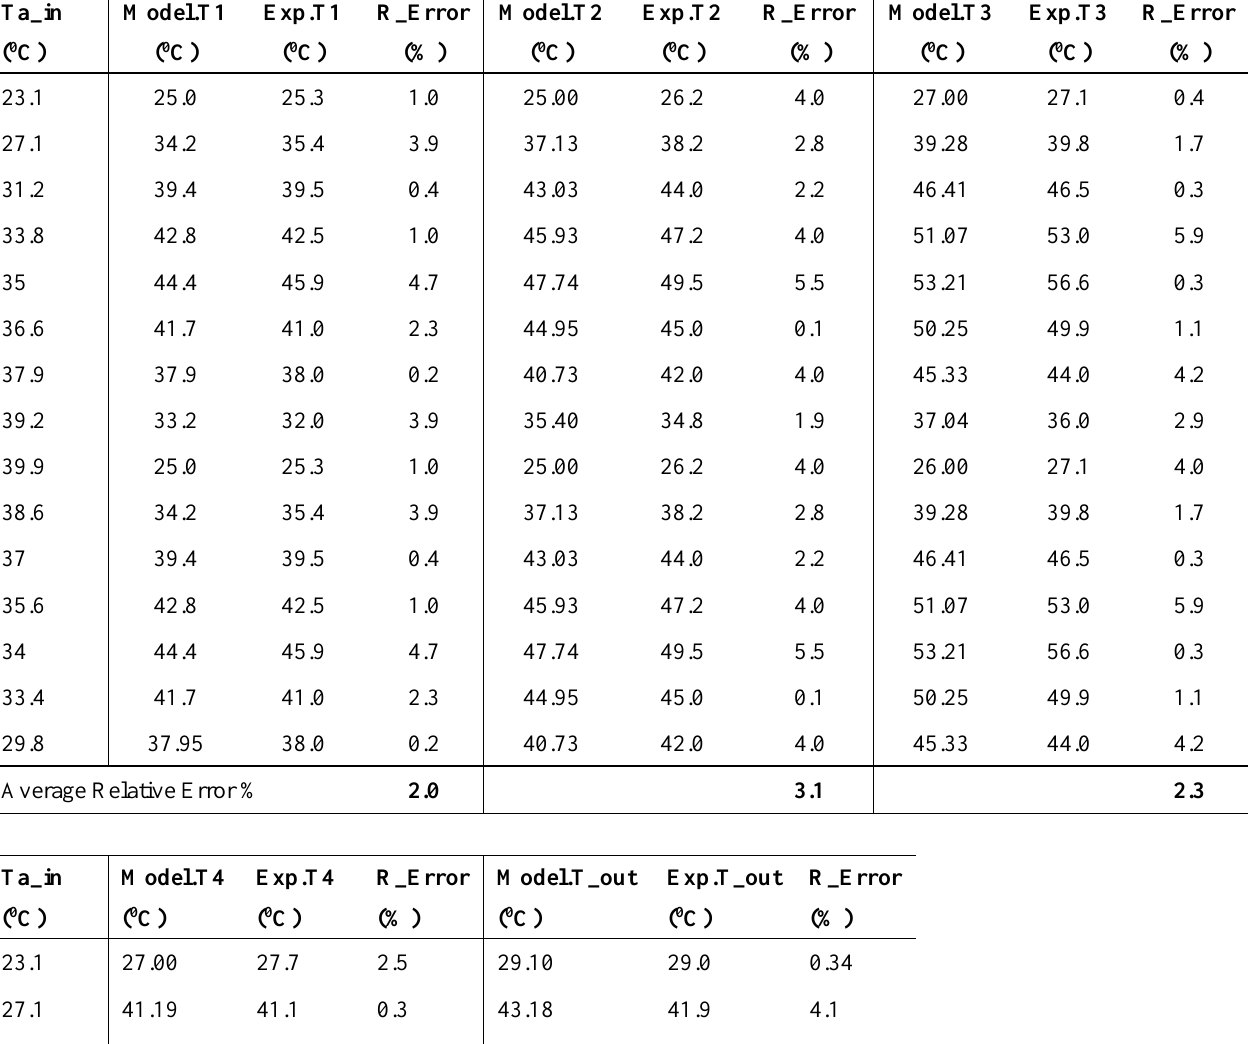
Table 3. Model Validation with Experimental